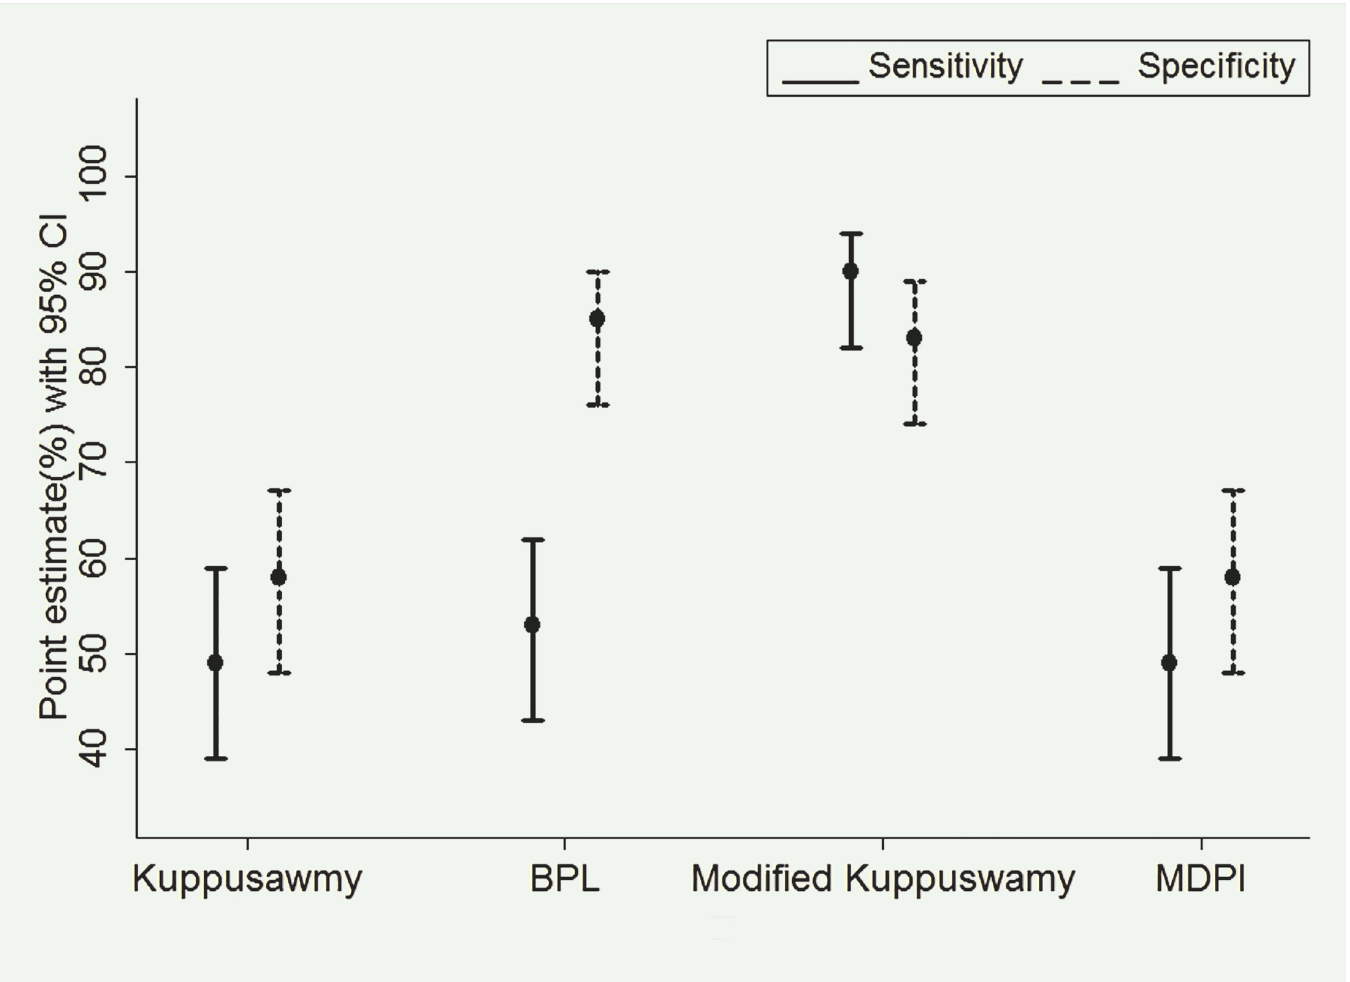
Fig 3. Sensitivity and Specificity for Socio-economic scales.